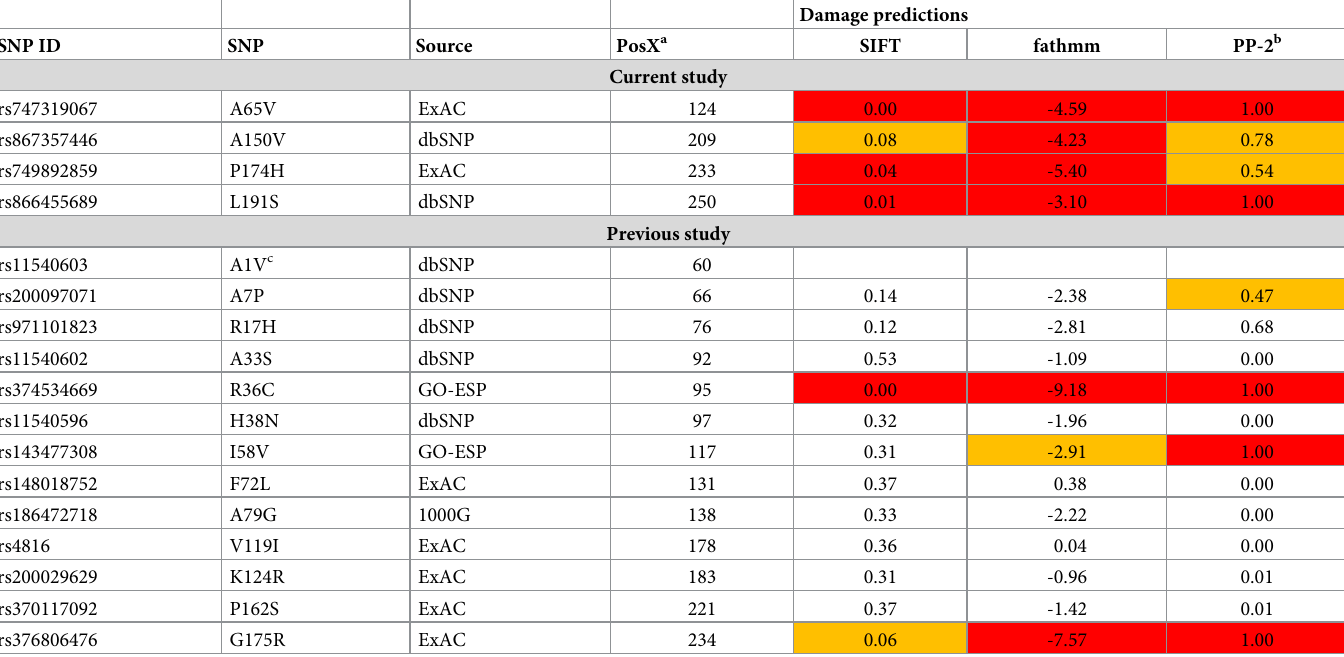
Table 1. PIMT missense variants explored in the current and previous studies.